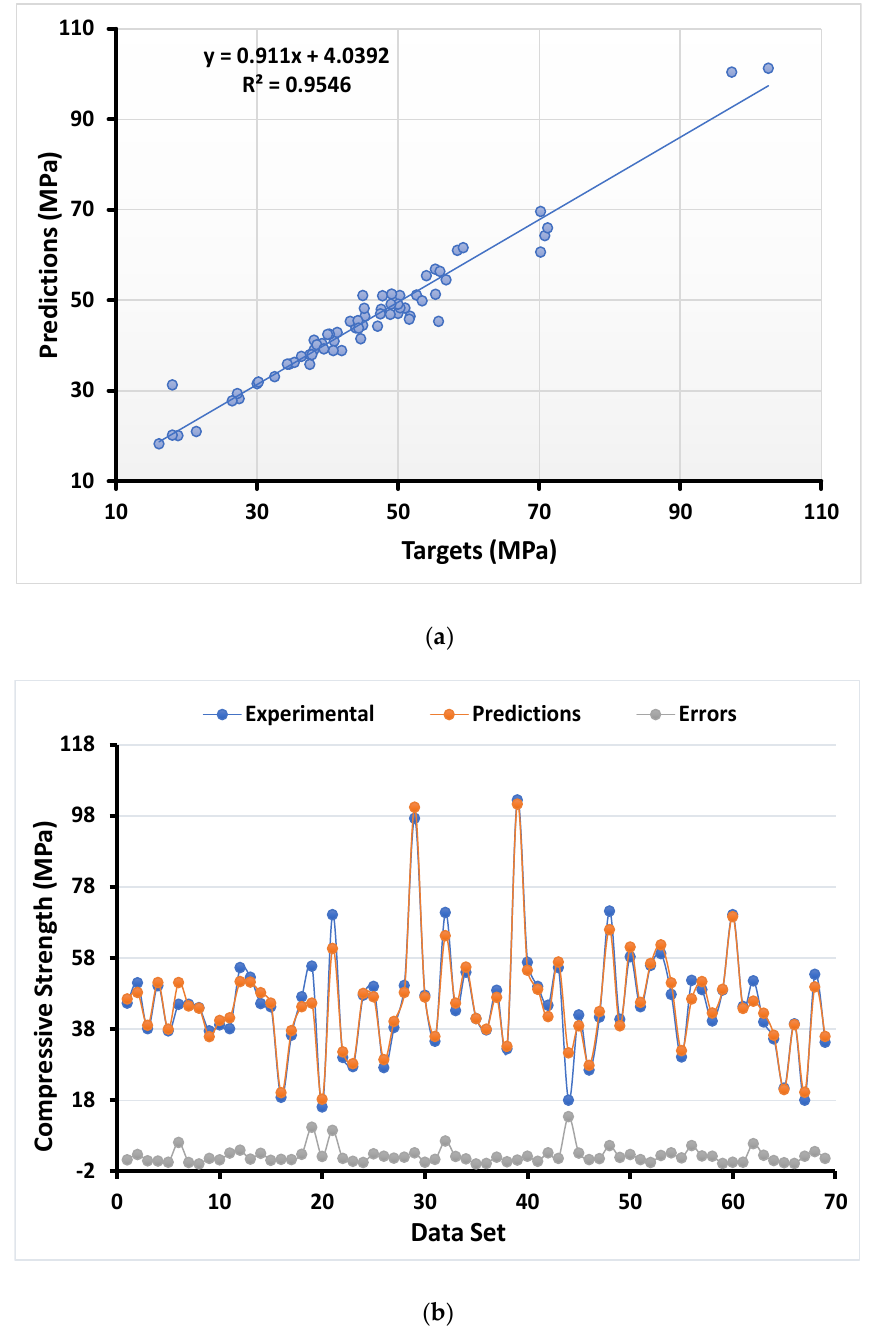
Figure 5. Numerical analyses representing the relationship between the predicted variables and targeted variables ( a ) along with their error distribution ( b ) for compressive strength using the AdaBoost regressor.